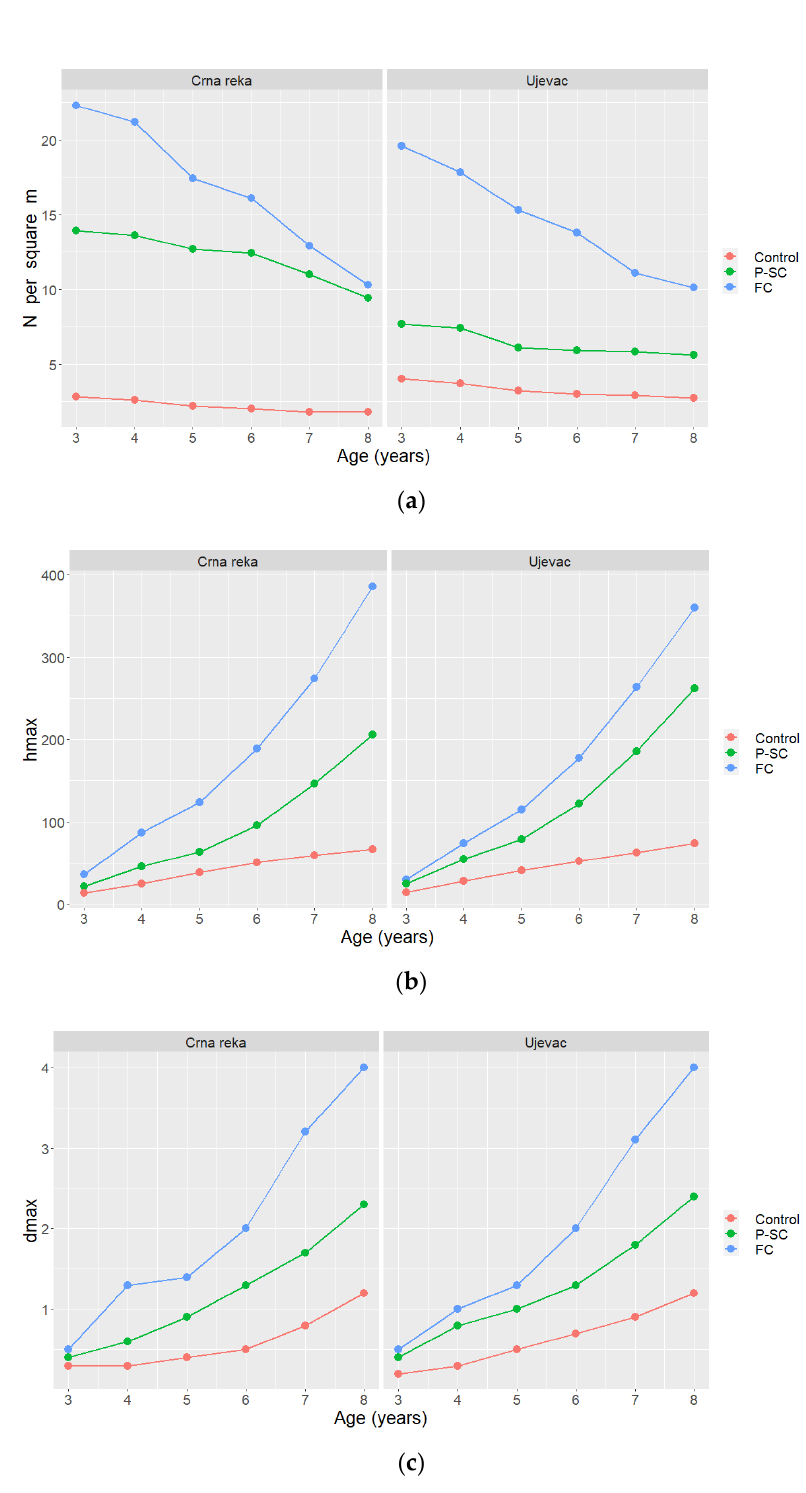
Figure 2. The number and growth characteristics of 3–8-year-old sessile oak seedlings in experimental units with different silvicultural treatments. ( a ) The average number of sessile oak seedlings—N (per m 2 ). ( b ) The maximum heights of sessile oak seedlings—hmax (cm). ( c ) The maximum root collar diameters of sessile oak seedlings—dmax